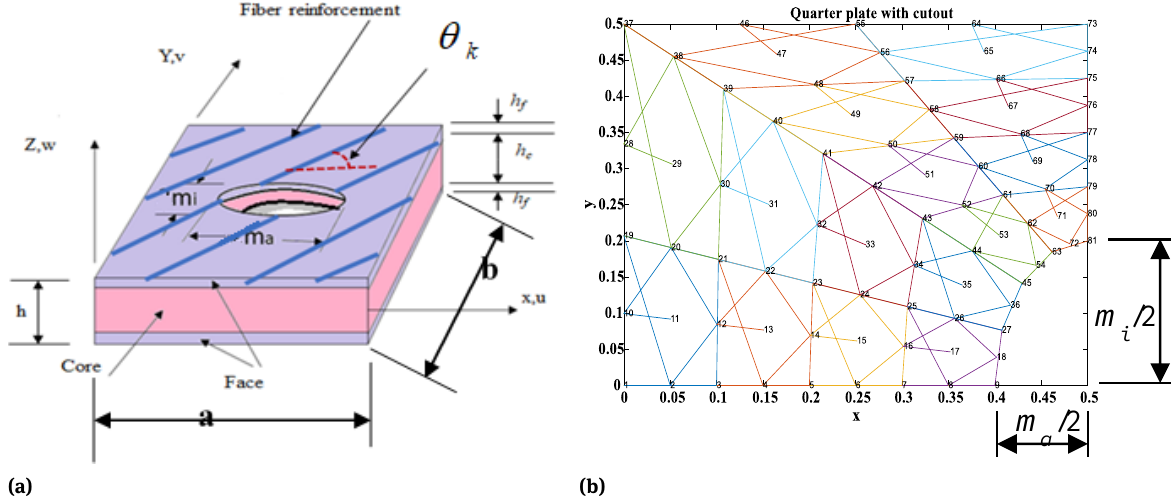
Figure 1: Laminated sandwich square plate with (a) elliptical cutout; (b) quarter part of elliptical cutout plate with FEM